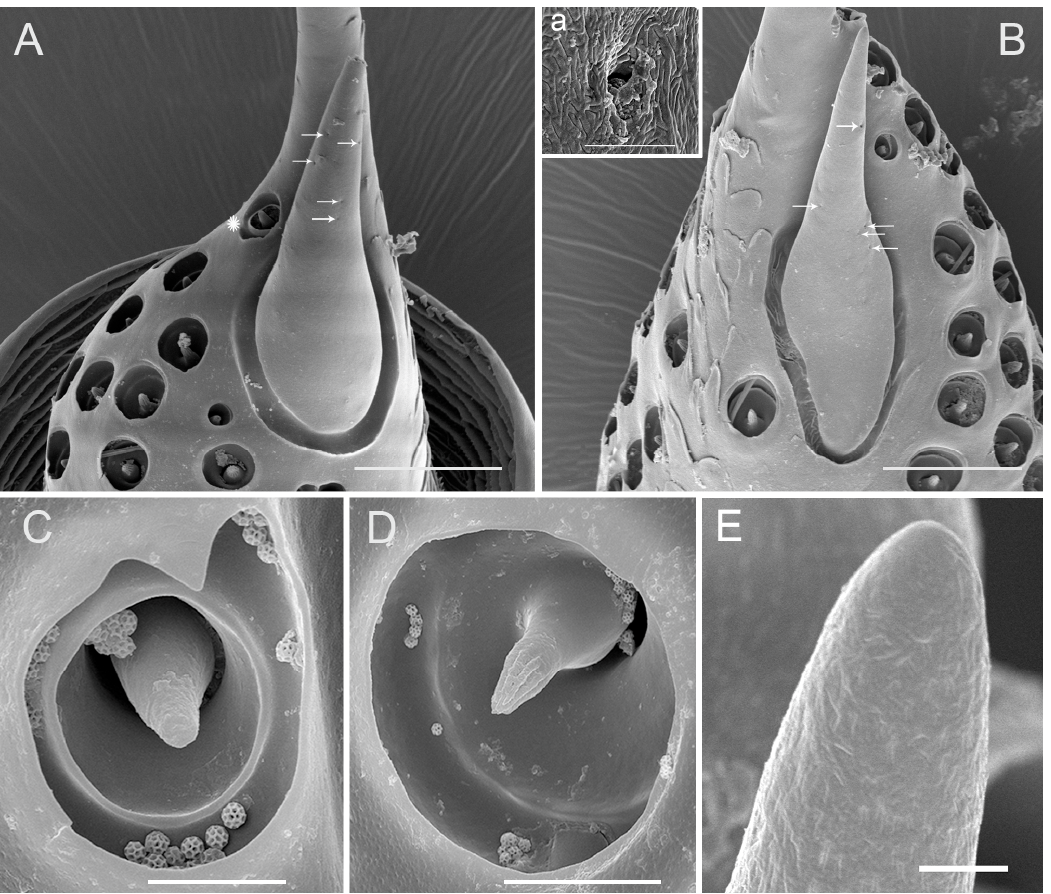
Figure 9. Antennal sensilla on the bulb-shaped portion of the flagellum of an adult Callitettix versicolor (Fabricius). ( A ) and ( B ) High magnification image of sensilla basiconica (SB2) in females and males, respectively (white stars indicate the location of SCo2 and the white arrow indicates the presence of several pitted wall pores), a. enlargement of pitted wall pore; ( C ) High magnification image of sensilla coeloconica 2 (SCo2); ( D ) High magnification image of sensilla coeloconica 3 (SCo3); ( E ) High magnification image of the apex of SB2, pores are visible. Scale bars: A = 25 μm; B = 25 μm; C = 2.5 μm; D = 5 μm; E = 1 μm; a = 0.5 μm.